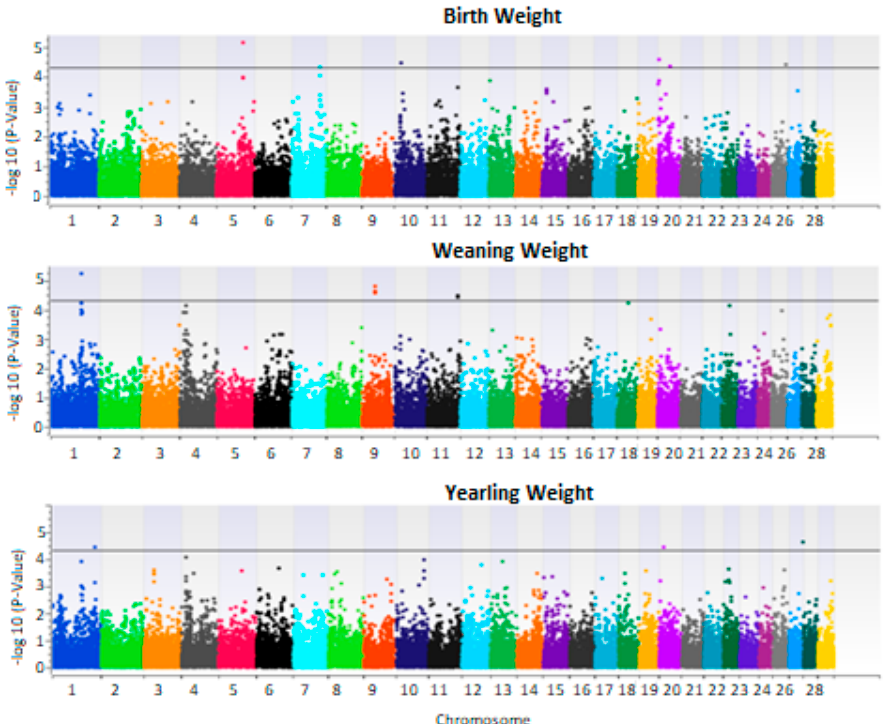
Figure 3. Manhattan plot of genome wide association analysis results of additive effects for birth using EMMAX, weaning and yearling weights. X-axis represents chromosomal locations and Y-axis is − log10 of p -values. The black line is − log10 (5e − 5).